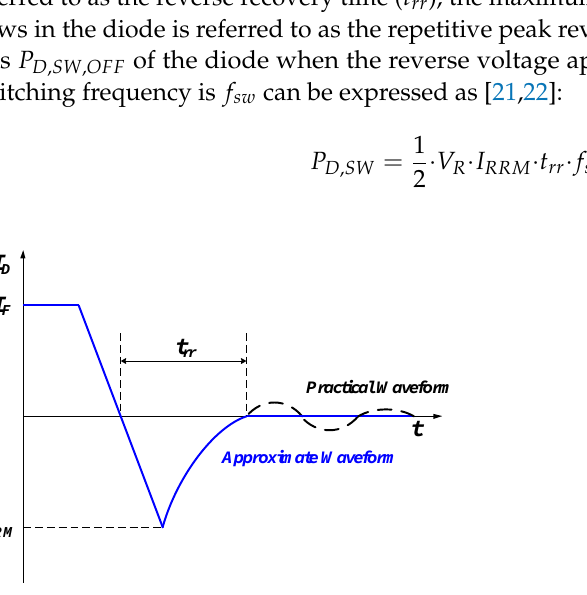
Figure 6. Diode reverse recovery characteristics.